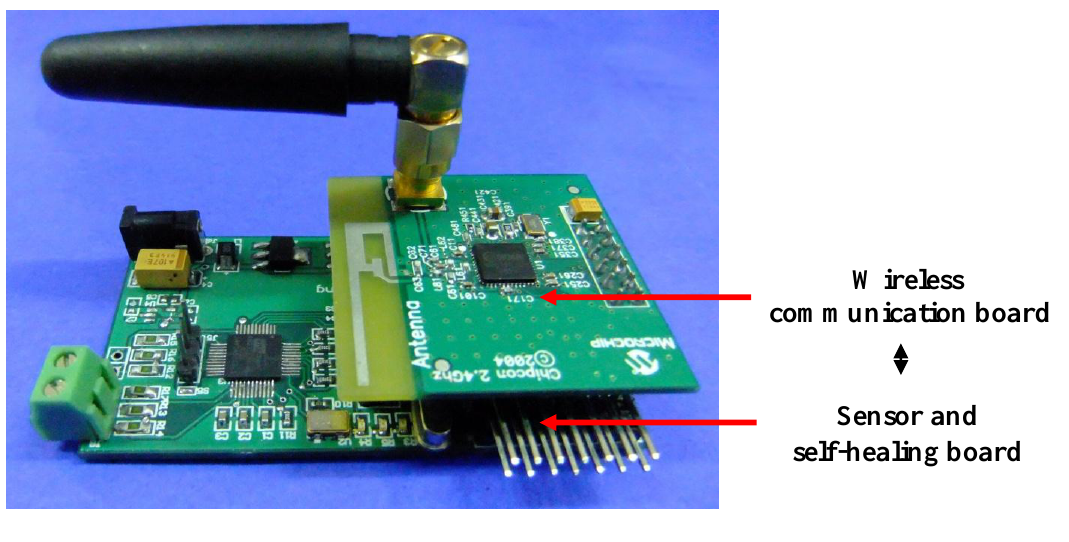
Figure 13. The developed FPAA-based self-healing WSN strain node.